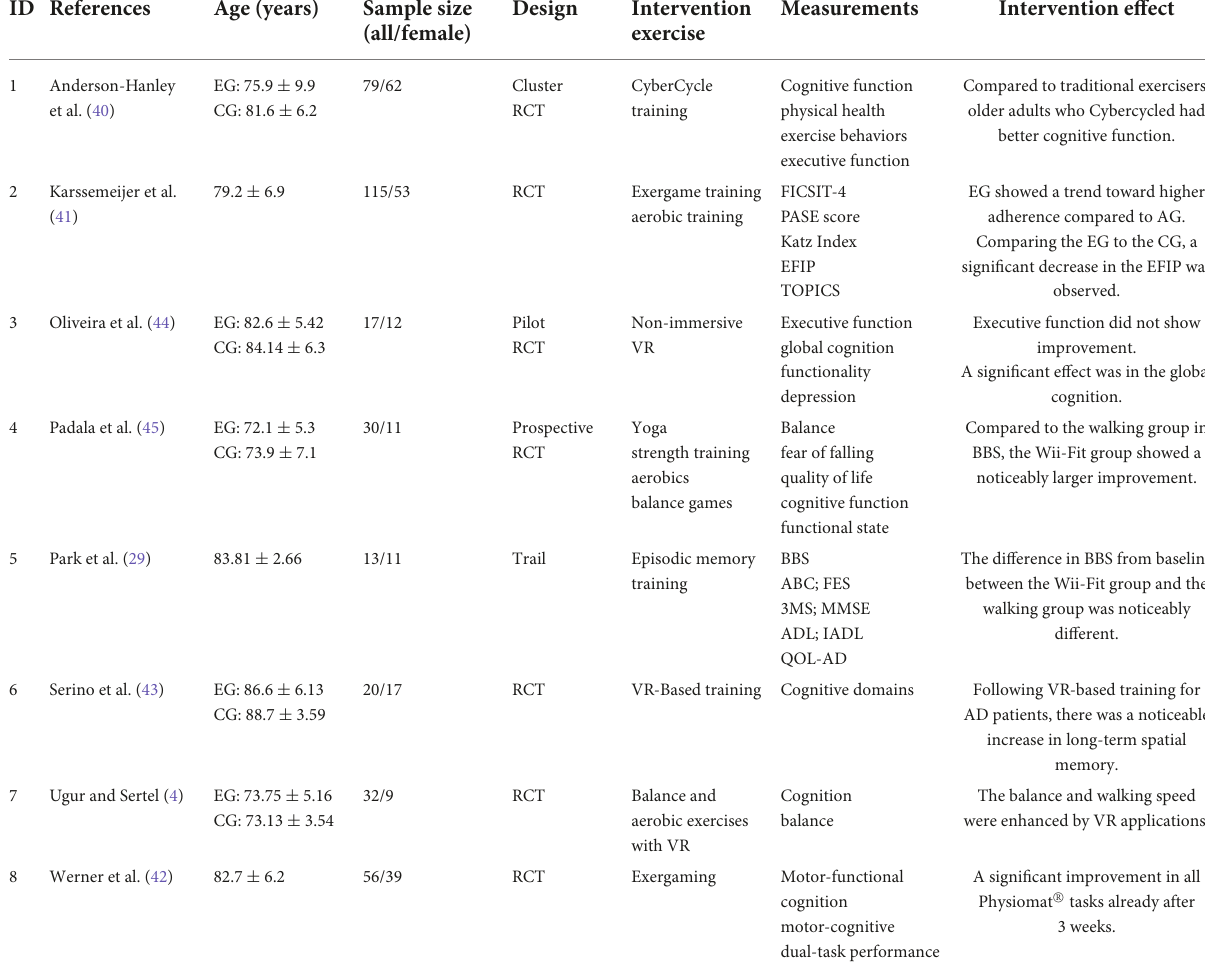
TABLE 1 Characteristics of the inclusion